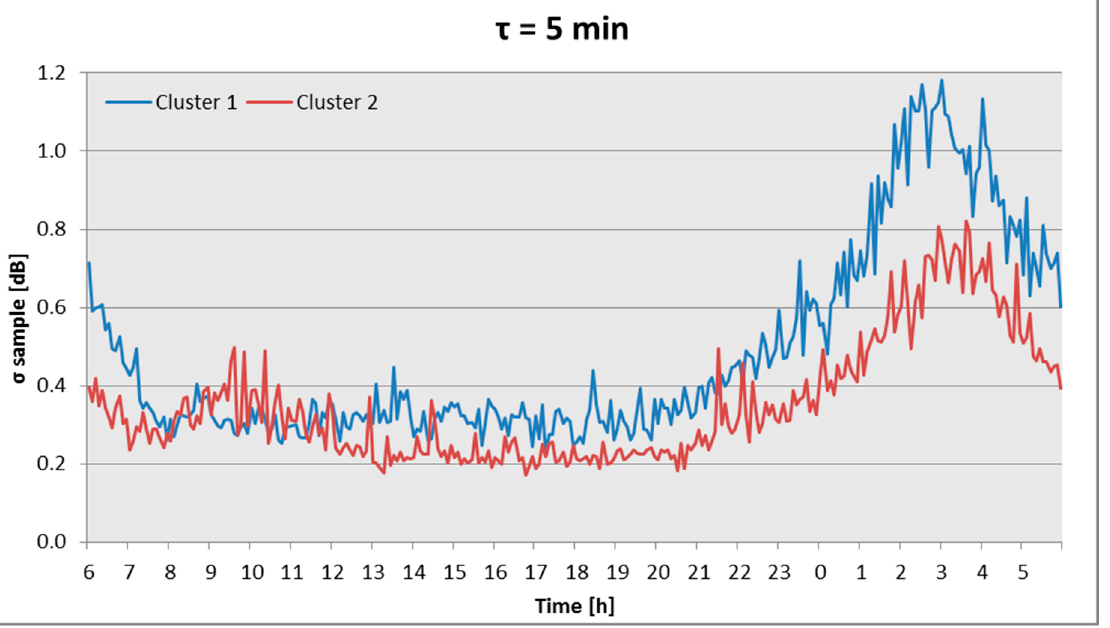
Figure 7. Expected deviation σ sample of the sample mean from the population mean calculated for a temporal discretization τ = 5 min.